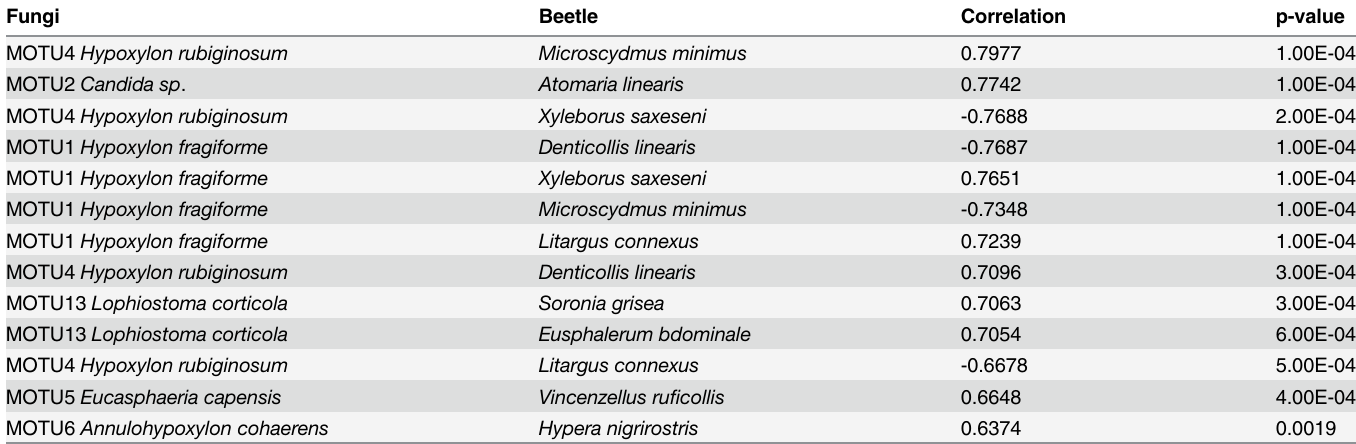
Table 1. Significant associations between wood-inhabiting fungi and beetles in the Hainich